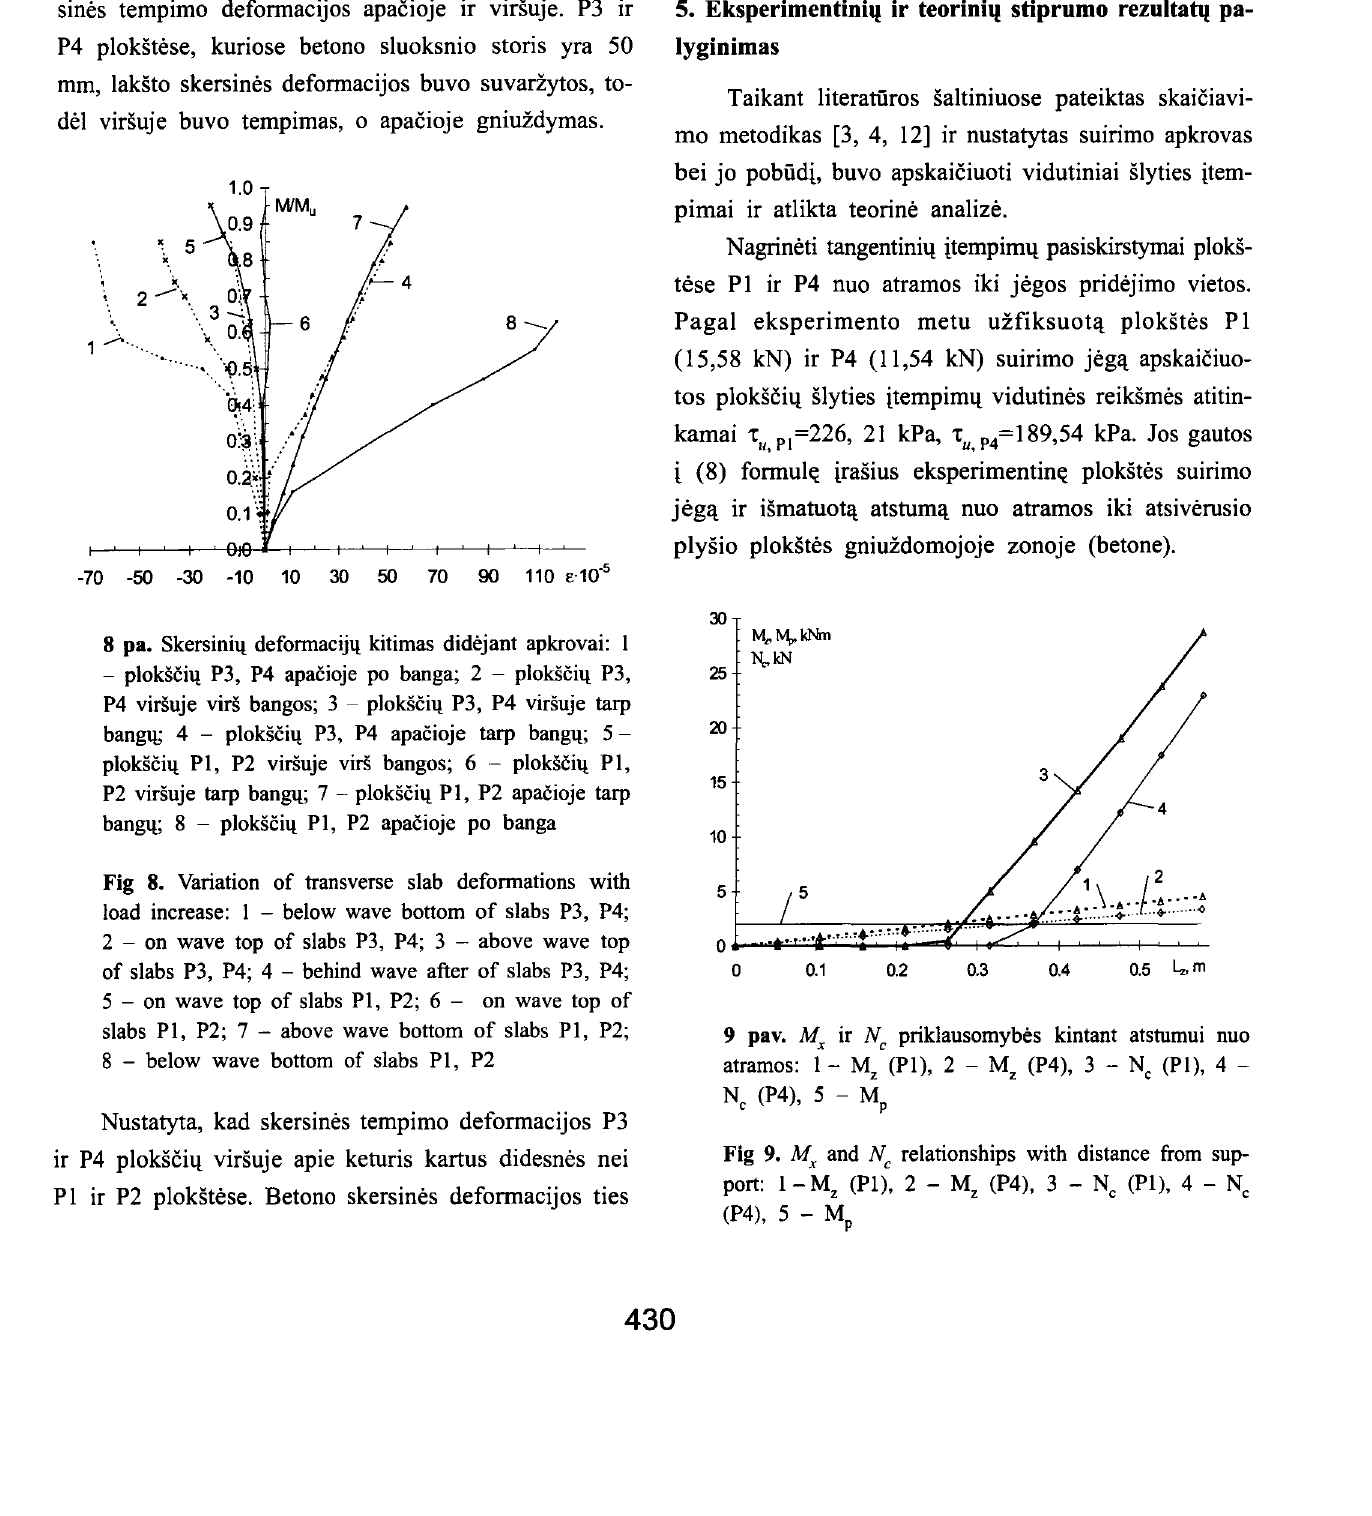
Fig 8. Variation of transverse slab deformations with load increase: I - below wave bottom of slabs P3, P4; 2 - on wave top of slabs P3, P4; 3 - above wave top of slabs P3, P4; 4 - behind wave after of slabs P3, P4;